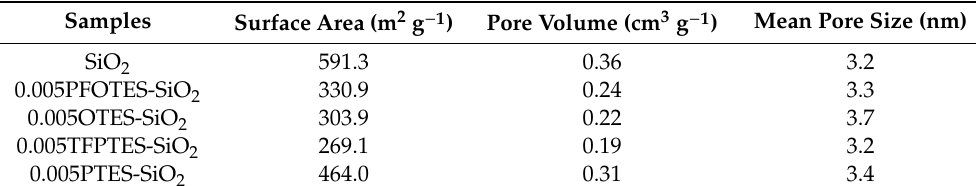
Table 1. Structural parameters of the pristine and silylated silica xerogels.